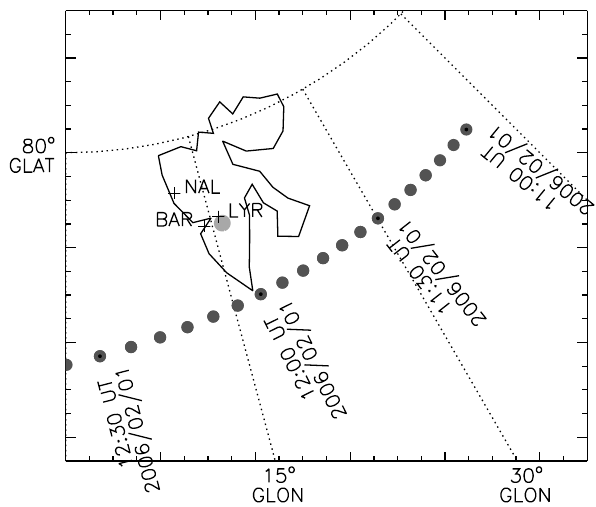
Fig. 1. A map showing the locations of the SPEAR heater patch Figure 1 at 100km altitude (light grey circle), the IMAGE and Barentsburg magnetometer sites used in this study (labelled crosses), and the mapped ionospheric footprint at 100km altitude of the Cluster-2 spacecraft (dark grey circles) during 11:00–12:30UT on 1 February 2006, in geographic